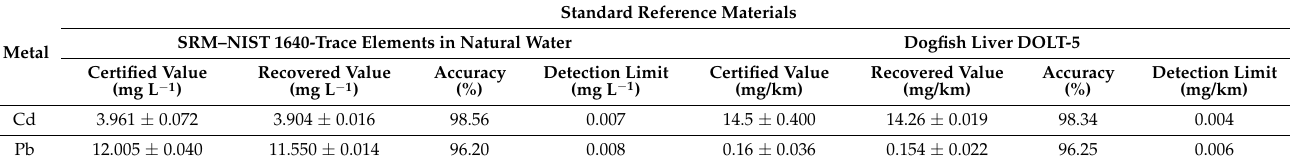
Table 1. Cd and Pb concentrations in standard reference materials and accuracy and detection limits determined by ICP-MS